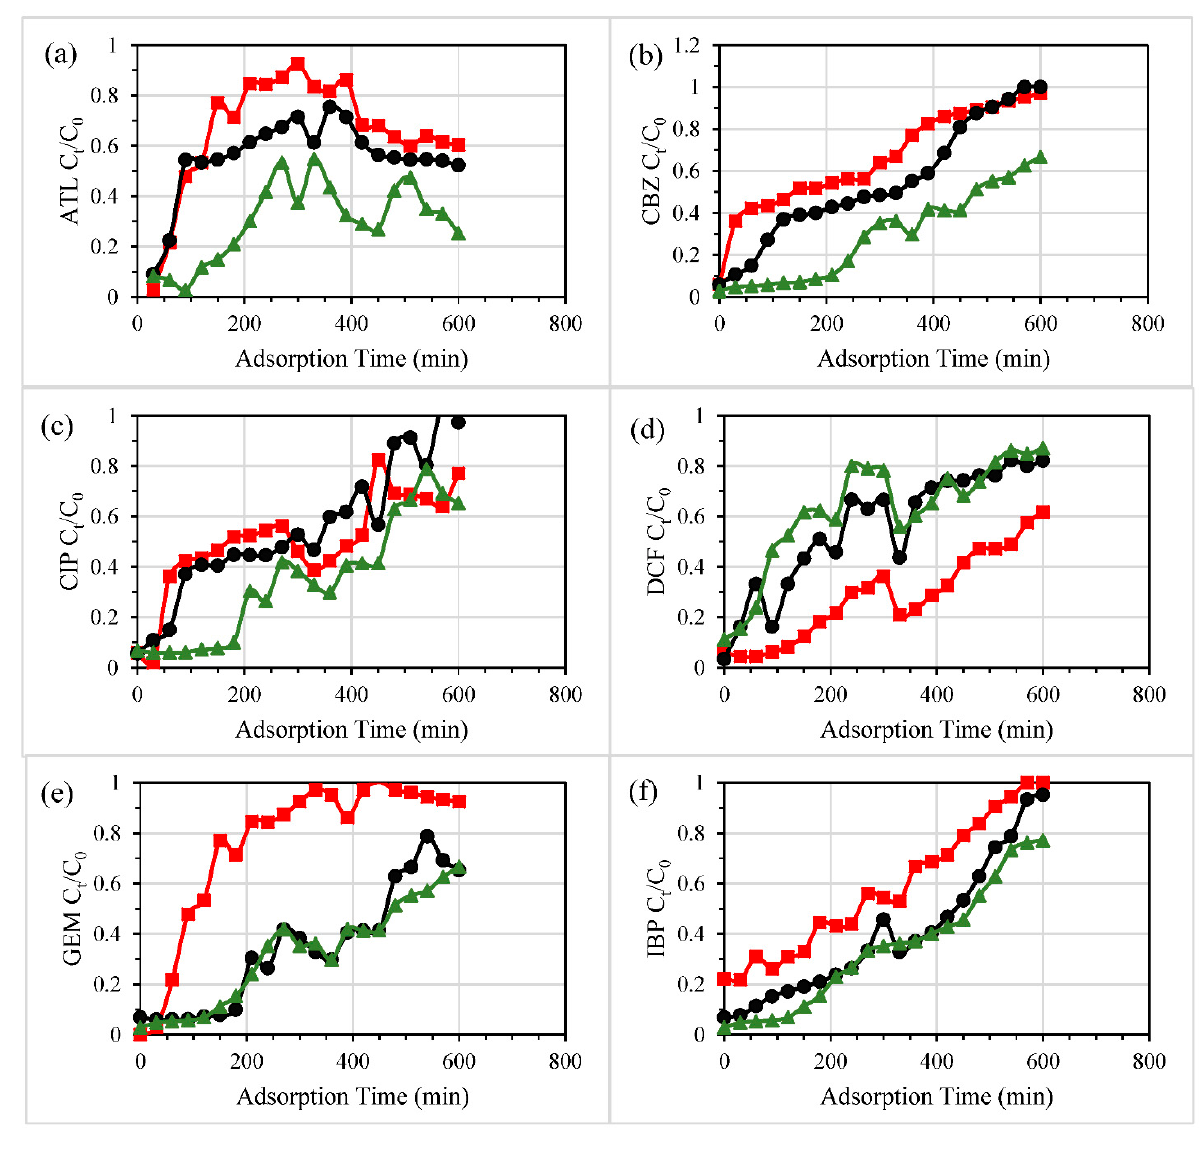
Figure 4. Transport and decontamination of ( a ) ATL, ( b ) CBZ, ( c ) CIP, ( d ) DCF, ( e ) GEM, and ( f ) IBP from EC-contaminated DW (conc. 10.5 mg/L) at flow rates of 0.5 mL/min through sand columns packed with PG in two different configurations (one or two PG layers) compared to a control sand column.